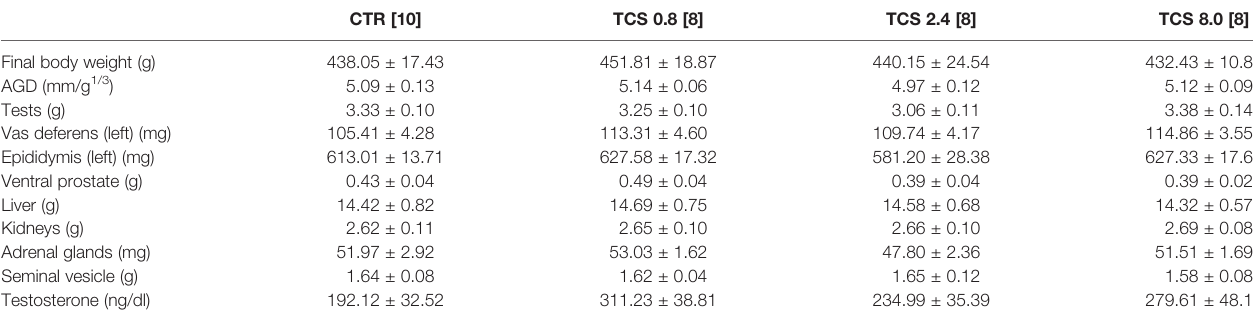
TABLE 2 | Body weight, AGD, organ weights, and plasma testosterone quanti fi cation of male rats of F1 generation at PND